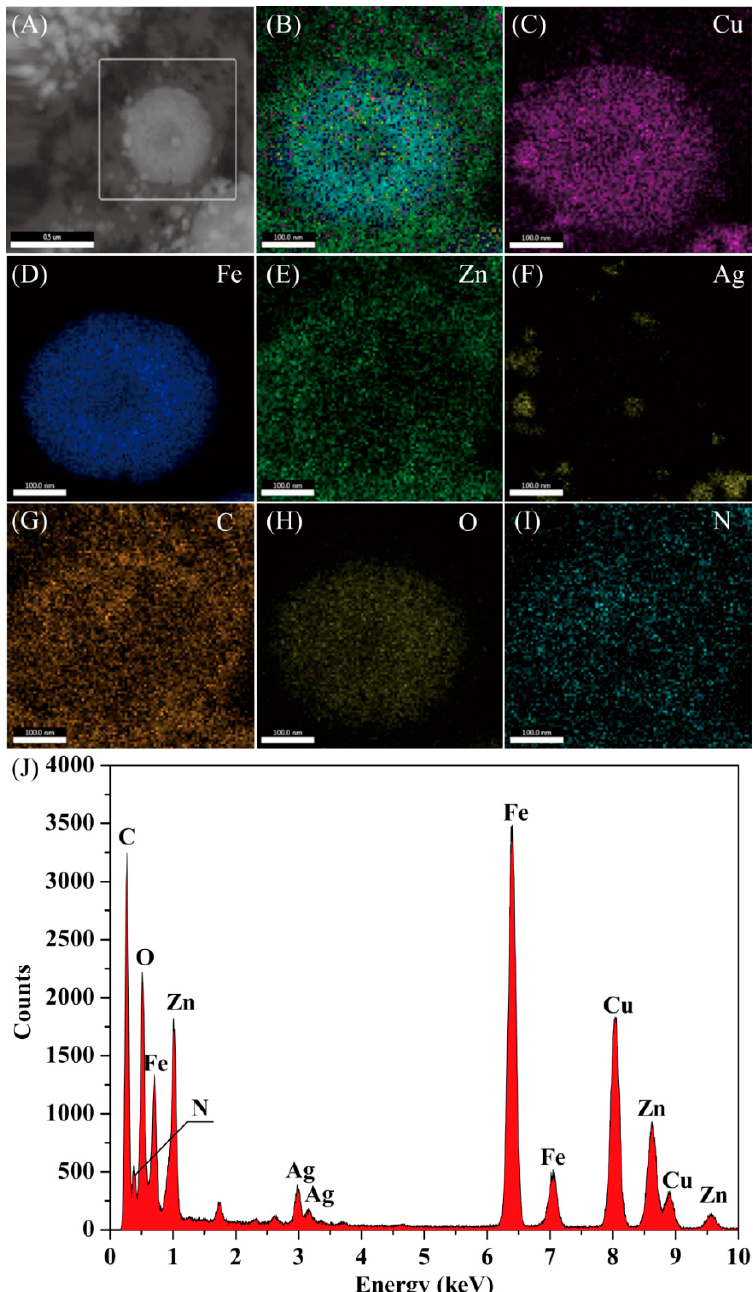
Figure 2. Representative high-angle annular dark field scanning TEM (HAADF-STEM) images and energy-dispersive X-ray (EDX) elemental mapping of Cu, Fe, Zn, Ag, C, O, and N ( A – I ) and the EDX spectrum ( J ) of the CuFe 2 O 4 /CNC@Ag@ZIF-8 nanocomposites.